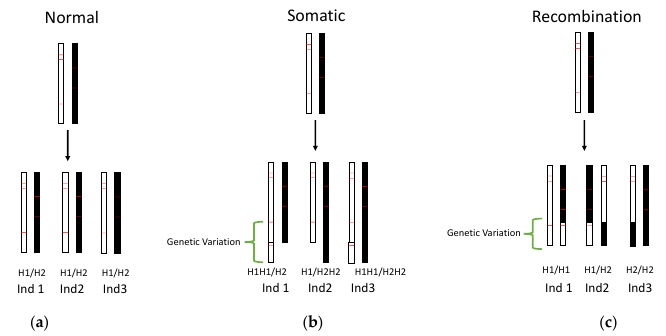
Figure 3. Processes that lead to genetic variants include somatic mutations and recombination. Three hypothetical scenarios are shown: ( a ) Normal state [no Structural Variants (SVs)]; ( b ) SV arising from somatic mutation; and ( c ) genetic variation (arising from recombination between individuals). Three individuals are represented (e.g., Ind 1, 2, and 3) and their corresponding haplotypes (H1 and H2). Haplotypes: H1, black; H2, white. Green brackets, genomic regions with variation; red lines, hypothetical SNPs that distinguish haplotypes. ( b ) Individuals with somatic SVs (e.g., amplification, assuming duplication occurs by tandem duplication) show an increase in haplotype (H1H1/H2, H1/H2H2, or H1H1/H2H2). ( c ) Genetic variants from recombination are likely to have allele combinations representing genotypes found in a Hardy–Weinberg equation (i.e., H1/H1, H1/H2, and H2/H2). In order to estimate the frequency of transmission of SVs to future generations of the population, the persistence times (the length of time an evolutionary lineage spends in a particular trait state), and the number of times each SV independently arose in the tree were calculated using ancestral state estimation. From the stochastic mapping analysis in BEAST v1.8.0, the genome-wide mutation rate for SVs varied from 2.5 × 10 −4 to 8.9 SVs per year. The duration of persistence times for each branch (represented by the length of the blue lines) were the average values taken from the posterior distribution of 100 trees (Figure 4). For example, the subtending branch of BS2016-10 had a longer average dwelling time in comparisons of SV persistence times in the posterior distribution to all other branches and their 100 simulated persistence times. A Mann–Whitney U-test was performed between the two distributions of the test branch and the population branches. Branches leading to isolates Pr1537 and Pr1652 also had longer persistence times in the amplified state than other branches (Figure 2).